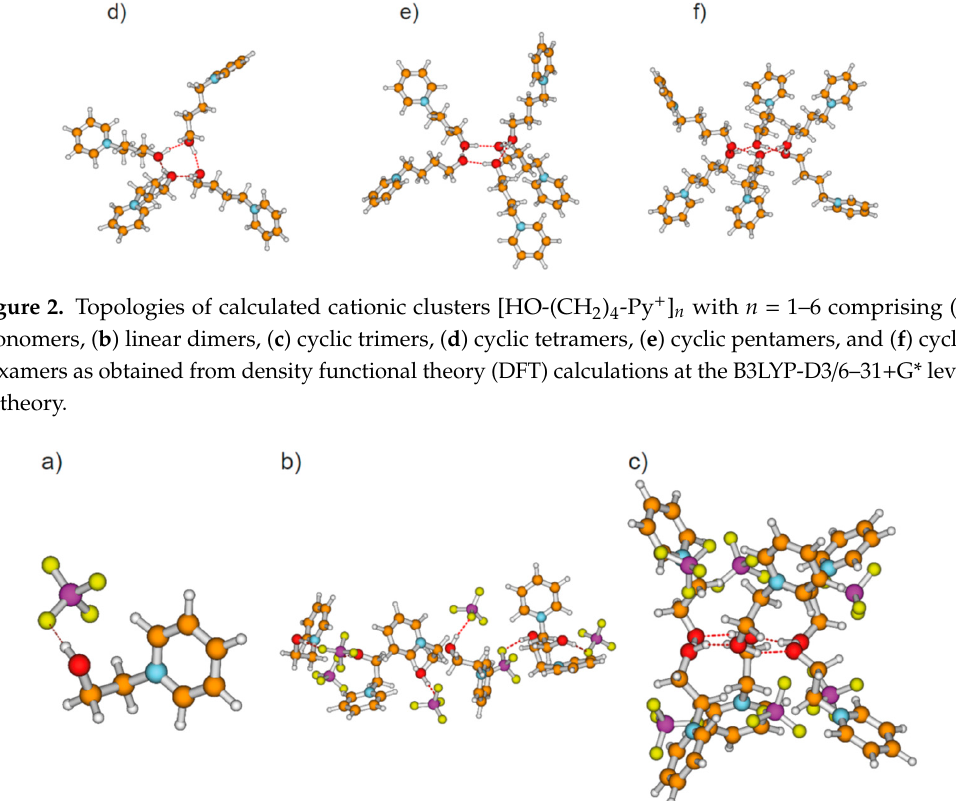
Figure 3. (a ) Simple ion pair with (c–a) hydrogen bond, ( b ) neutral hexameric cluster ([HO-(CH 2 ) 2 -